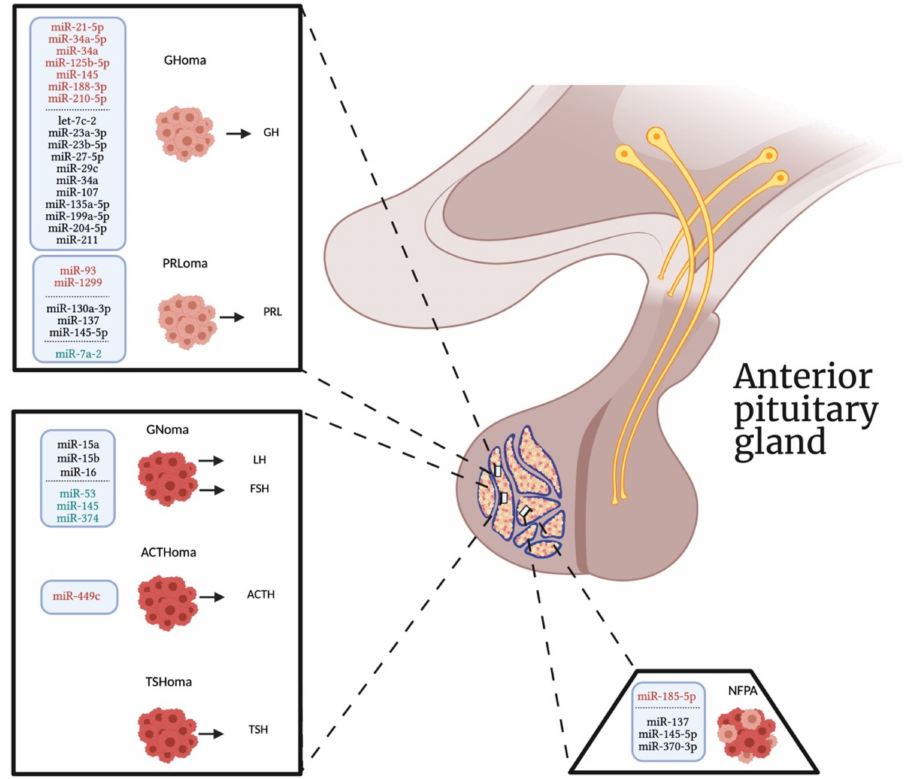
Figure 1. The altered expression of miRNAs according to the subtype of PAs. Red, black, and green colors indicate upregulated miRNAs, downregulated miRNAs, and dysregulated miRNAs levels, respectively. GHoma, growth hormone- secreting pituitary adenomas; PRLoma, prolactin-secreting pituitary adenomas; GNoma, gonadotropin-secreting pituitary adenomas; ACTHoma, adrenocorticotropic hormone-secreting pituitary adenomas; TSHoma, thyroid-stimulating hormone- secreting pituitary adenomas; NFPA, non-functioning pituitary